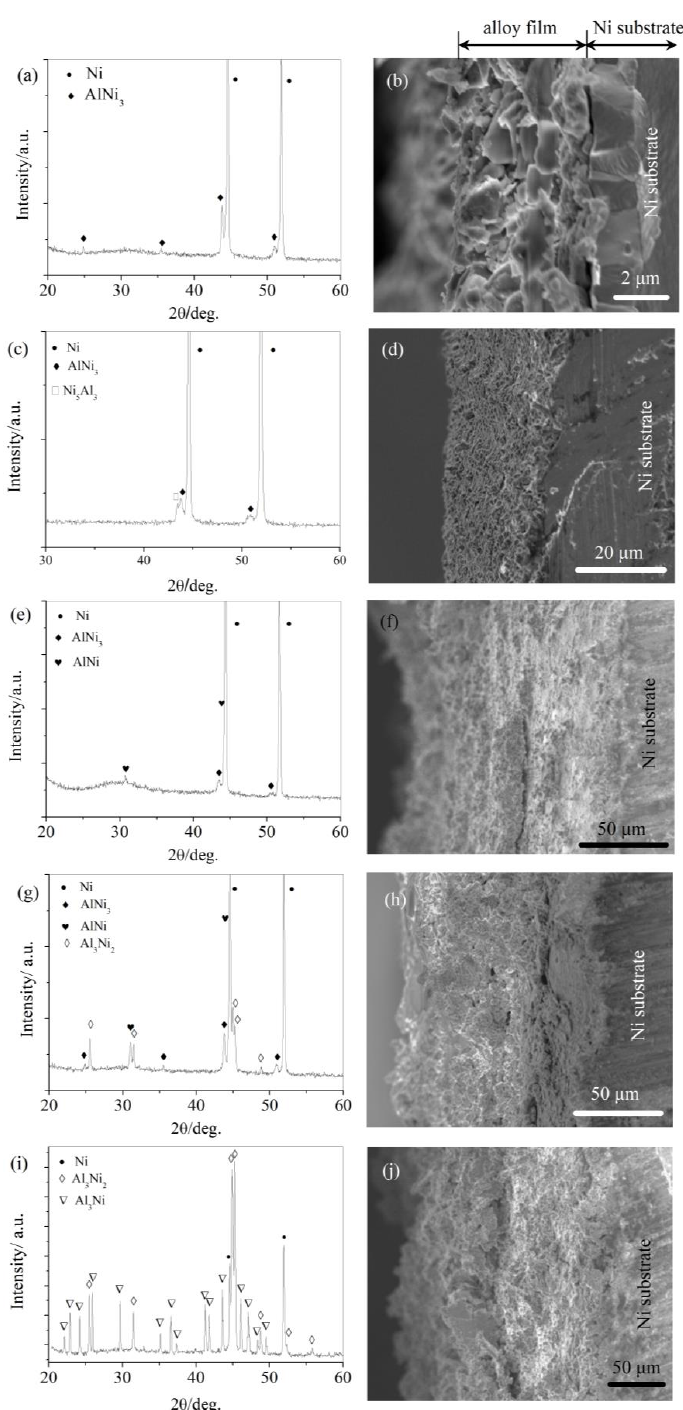
Figure 5. XRD and cross-sectional SEM image of samples obtained by potentiostatic electrolysis on Ni plate at different potentials from LiCl-KCl-AlCl 3 (2 wt.%) melts at 753 K: ( a , b ) − 1.0 V (vs. Pt) for 9 h; ( c , d ) − 1.17 V (vs. Pt) for 12 h; ( e , f ) − 1.28 V (vs. Pt) for 12 h; ( g , h ) − 1.37 V (vs. Pt) for 12 h; and ( i , j ) − 1.47 V (vs. Pt) for 12 h.